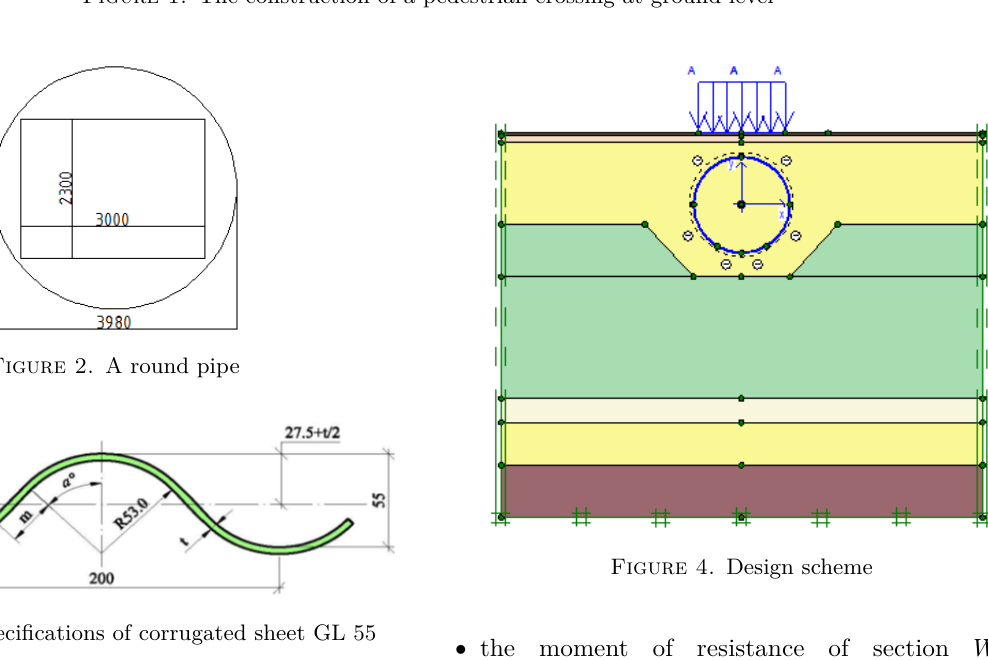
Figure 1. The construction of a pedestrian crossing at ground level